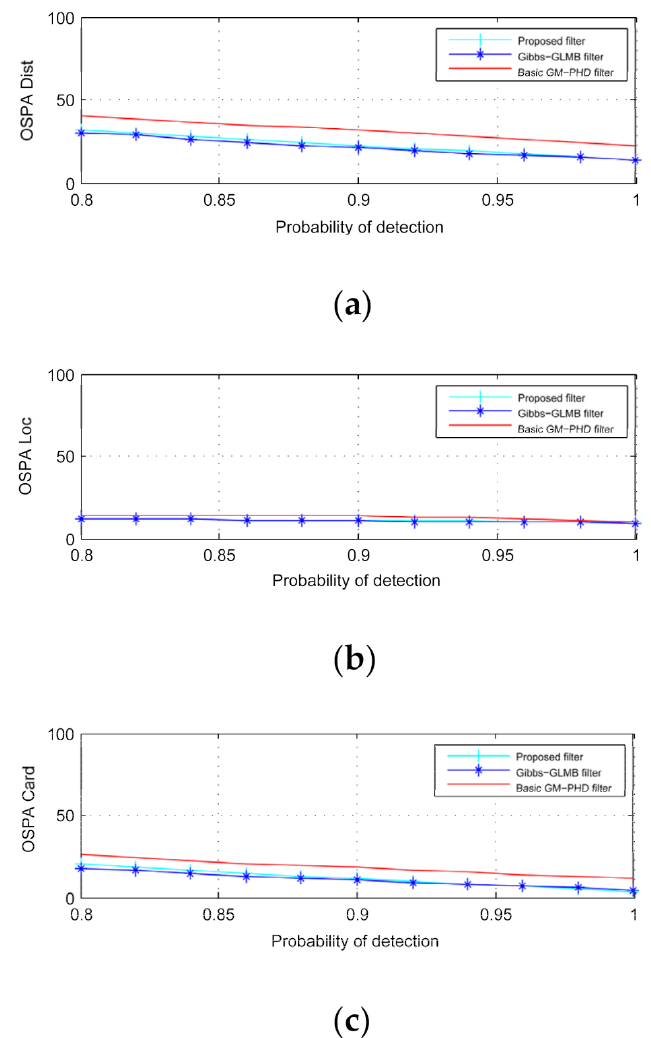
Figure 9. Comparison of different algorithms under various probabilities of detection for 250 sample runs ( λ = 100). ( a ) Average OSPA distances of different filters; ( b ) OSPA locations of different filters; ( c ) OSPA cardinalities of different